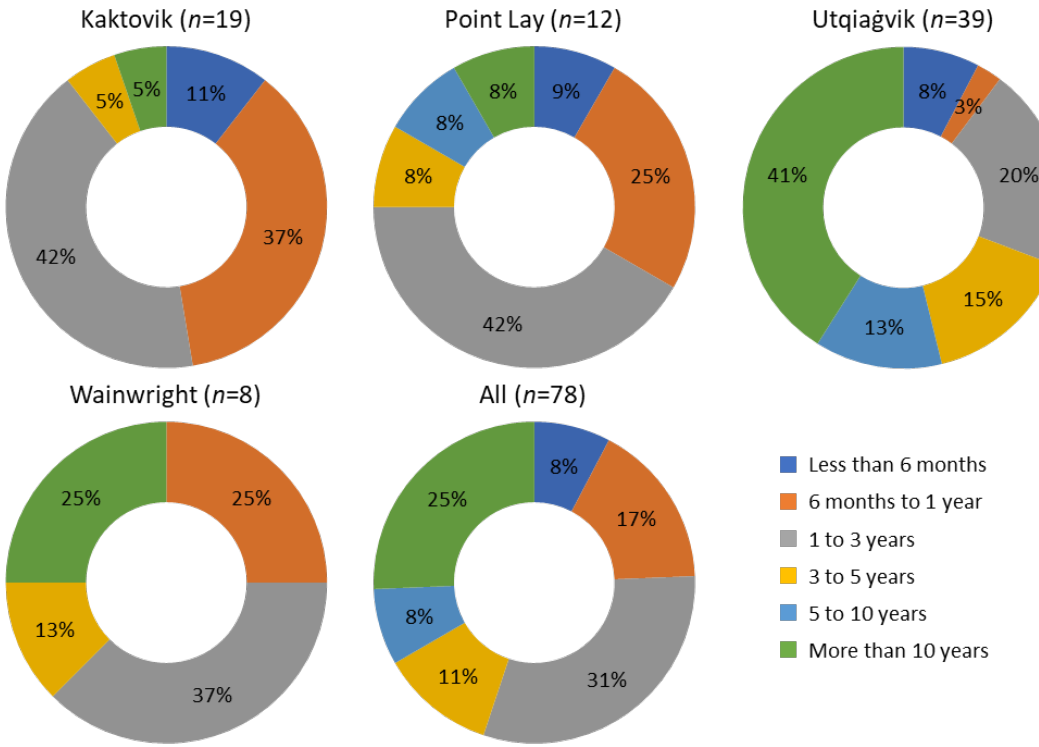
Figure 6. Time periods of observed coastal erosion. n is the sample size. Table 4. Comparison of the most reported types of civil infrastructure affected by permafrost thaw and coastal erosion and their reported time periods.